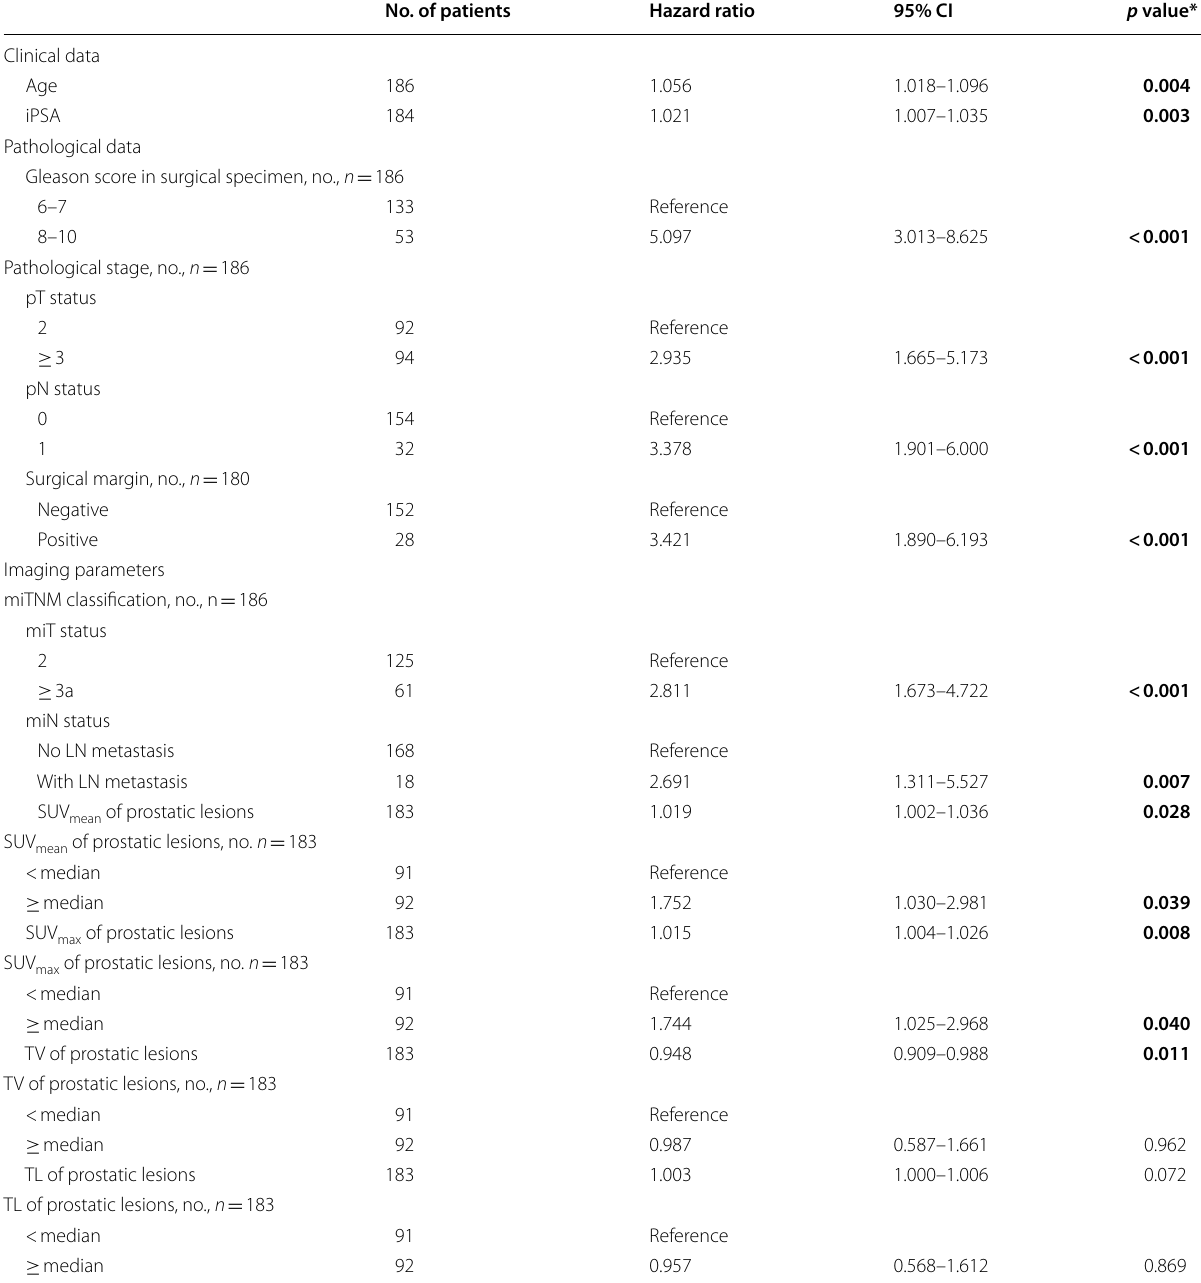
Table 6 Univariable analysis for the association of baseline factors with BCR‑free